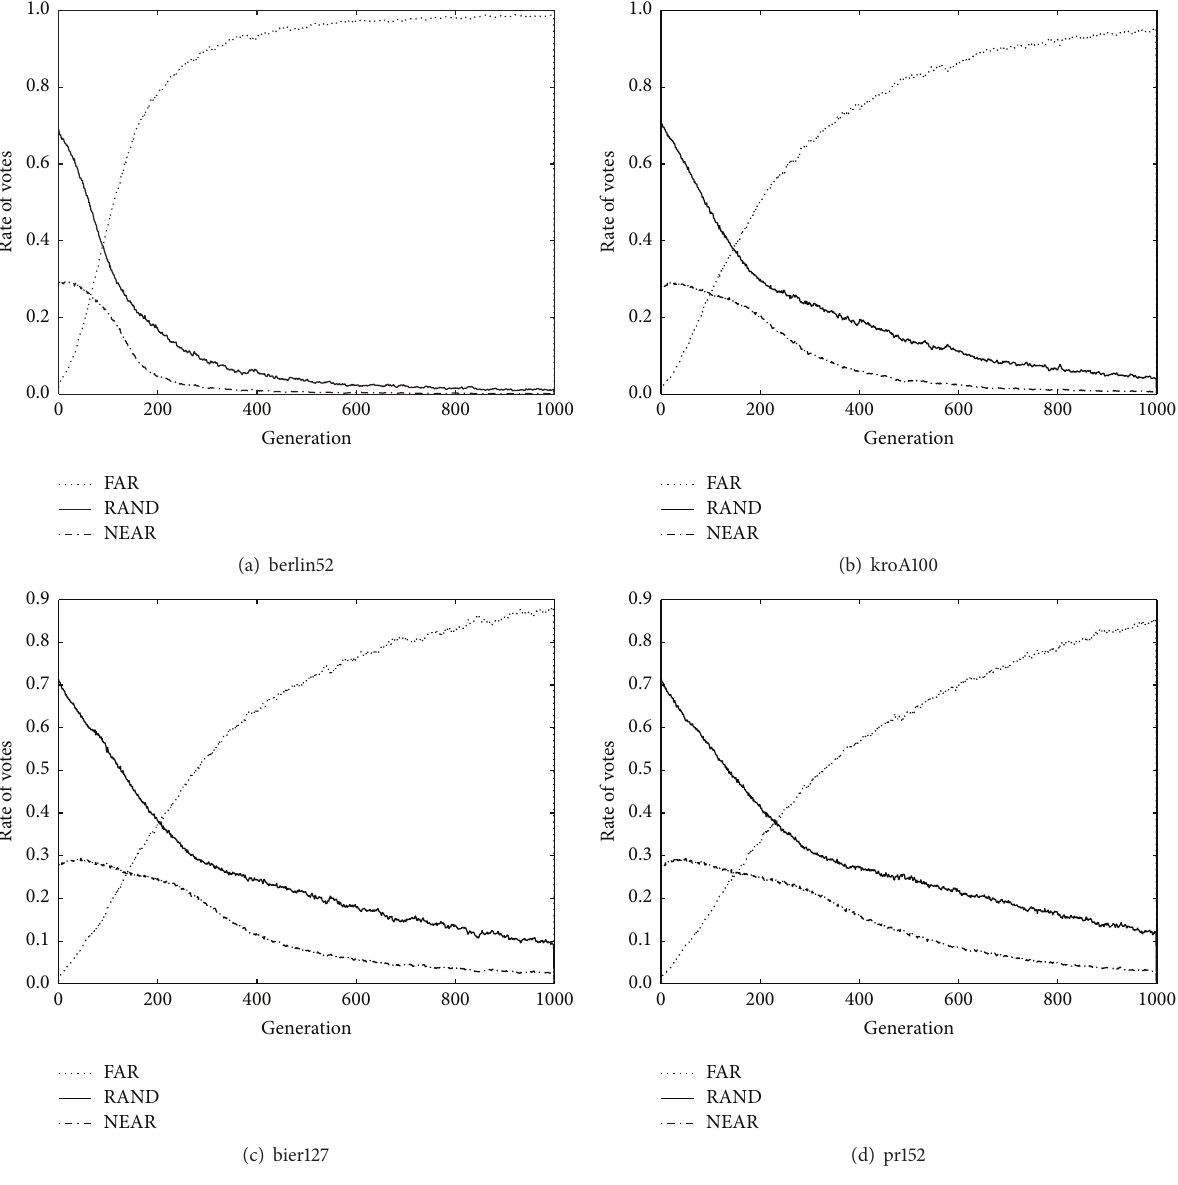
Figure 4: Voting rates of schemes in